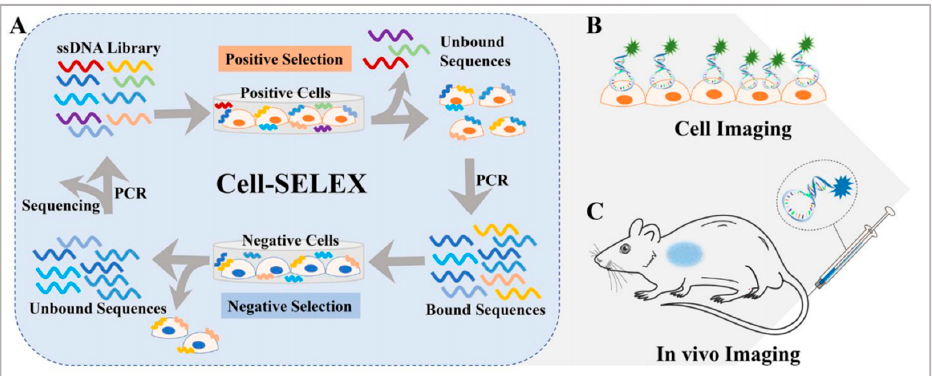
Figure 1. ( A ) Basic principle of the cell-SELEX method and applications for ( B ) cell imaging and ( C ) in vivo imaging. Reprinted with permission from [29]. Copyright © 2020 American Chemical